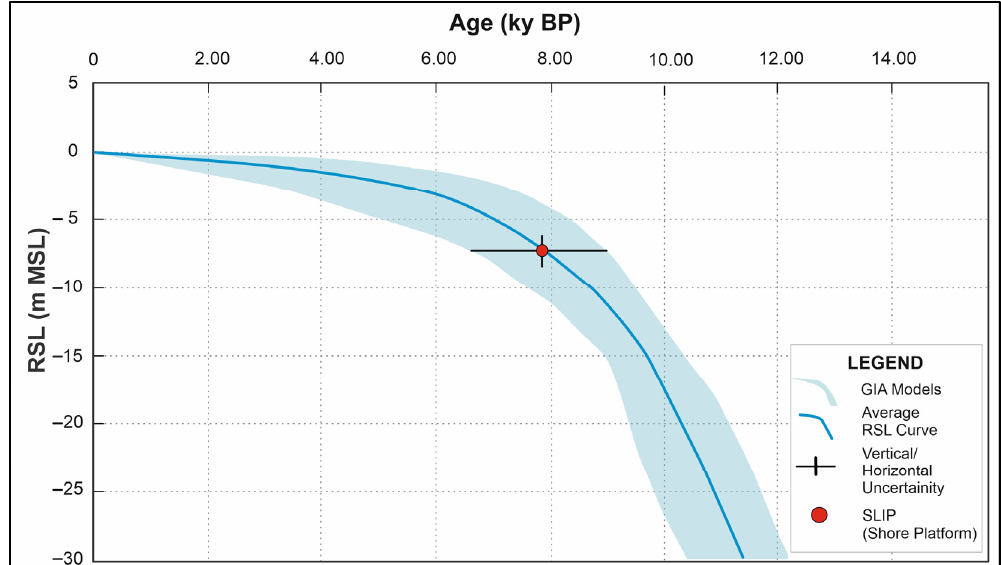
Figure 8. The RSL data derived from the Holocene shore platforms and the GIA predictions for the Gulf of Naples [99]. Table 4. Maximum (RRs max), minimum (RRs min) and average (RRs med) retreat rates for the four sectors of the Punta Licosa Promontory (PL1, PL2, PL3,